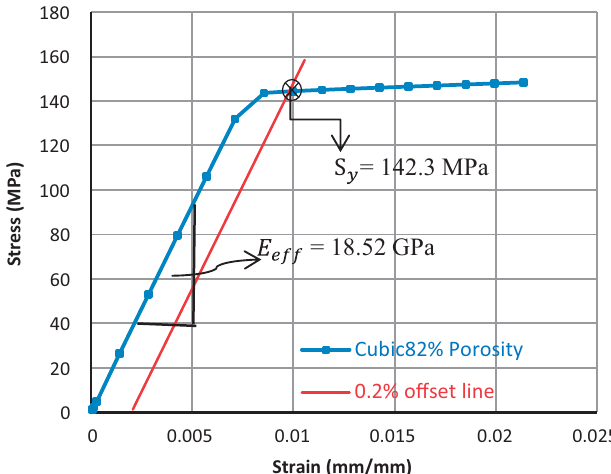
Fig. 7. Yield strength by 0.2% offset method and effective elastic modulus of Cubic (82) model (similar method applied to all porous